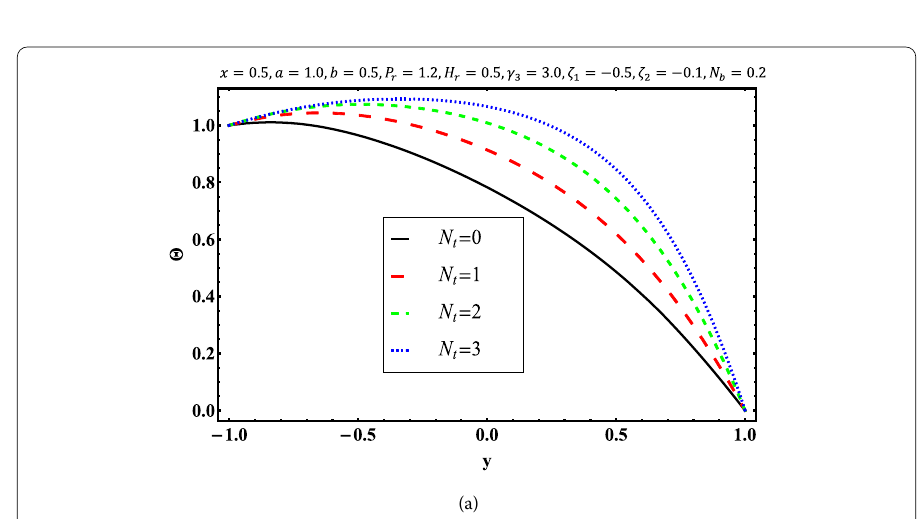
Figure 14 For different values of N t , ( a ) temperature distribution Θ and ( b ) concentration distribution Ω